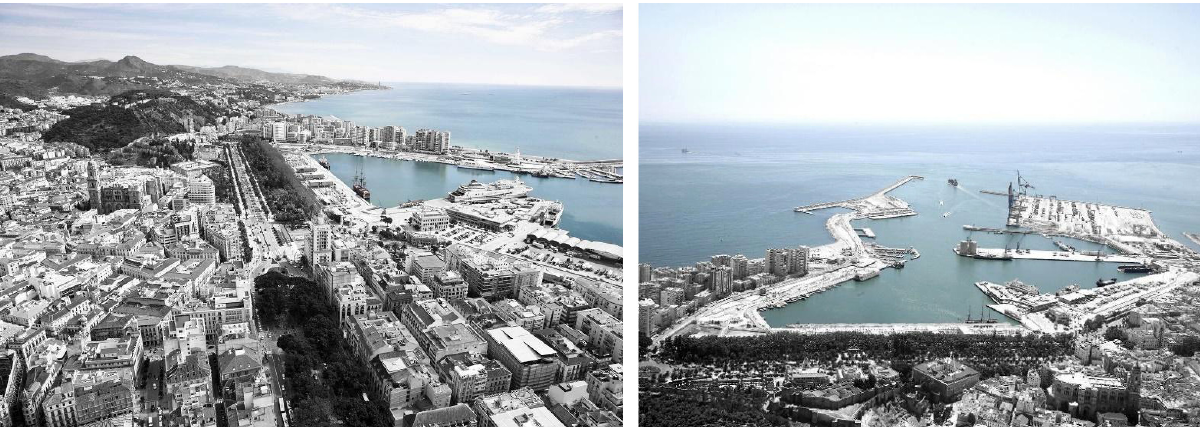
Figure 2. Images of the port city of Malaga with the huge traffic barrier that separates them. Source: Pedro Marin, edited by María J. Andrade